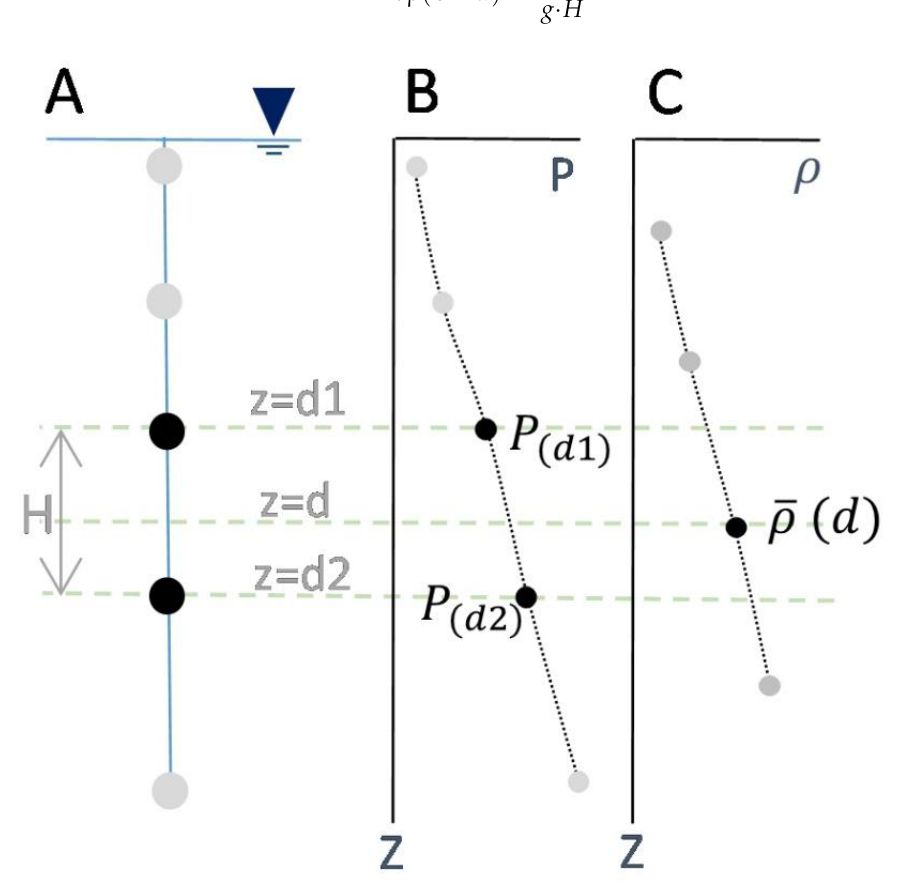
Figure 1. Schematic illustration of the setup of the hydrostatic densitometer. ( A ) Array of pressure sensors along a submerged vertical chain. The pressure sensors represented by black dots are located at z = d 1 and z = d 2 with a vertical separation of H ; z = d is the midpoint between the sensors. ( B ) Pressure–depth profile; pressures at z = d 1 and z = d 2 are represented with black dots. ( C ) Density profile resolved from the pressure sensor and hydrostatic relations (Equations (4) and (6)). The average density (Equation (6)) at depth z = d is represented with a black dot.